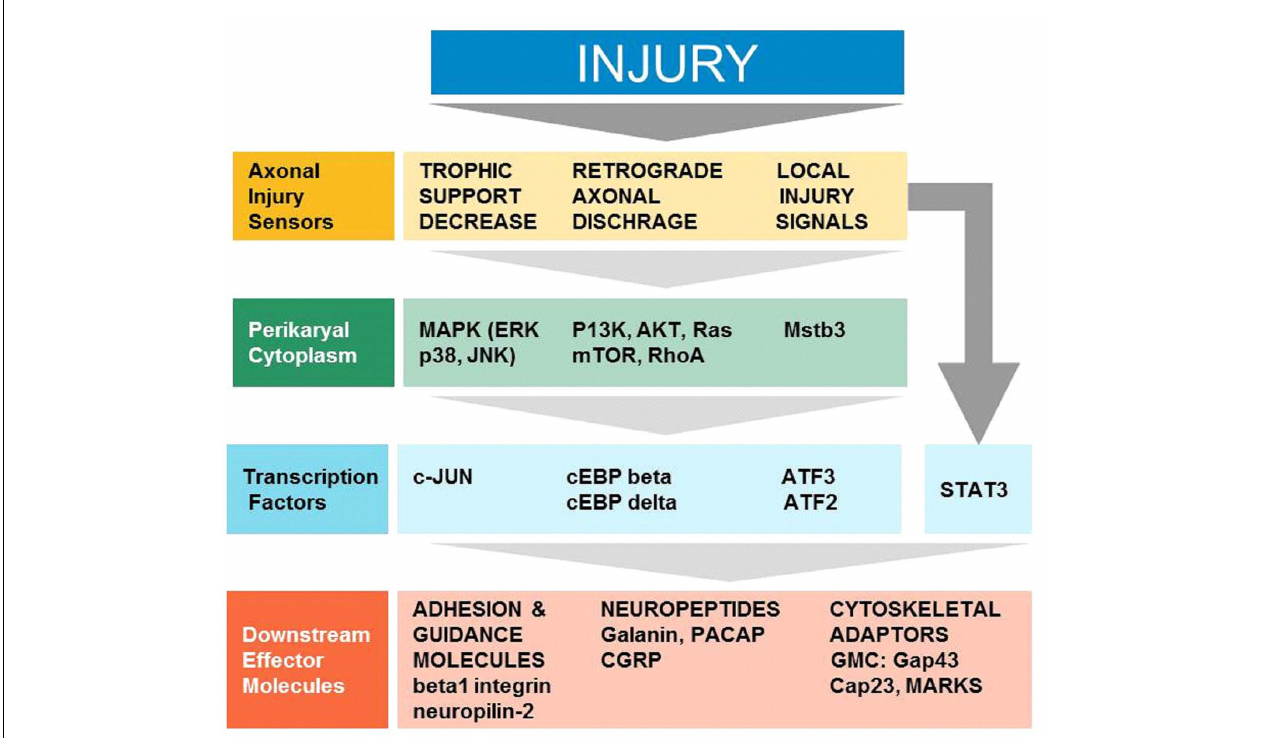
FIGURE 1 | Cellular signaling in successful regeneration, from early sensors of injury, to cytoplasmic signals, transcription, and downstream effectors (Modified Raivich, 2011).